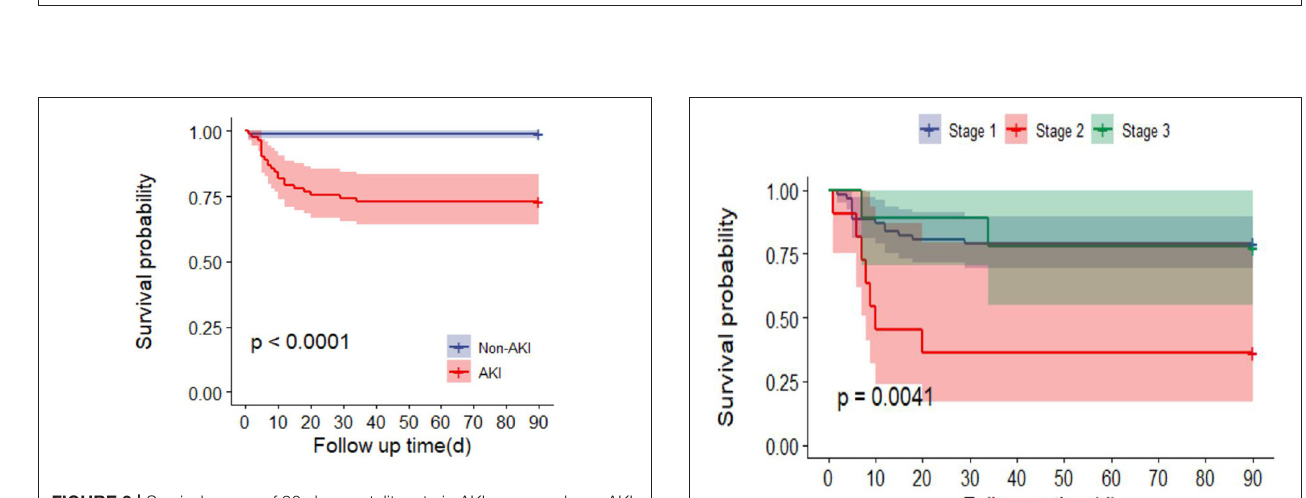
FIGURE 3 | Survival curves of 90-day mortality rate in AKI group and non-AKI group.